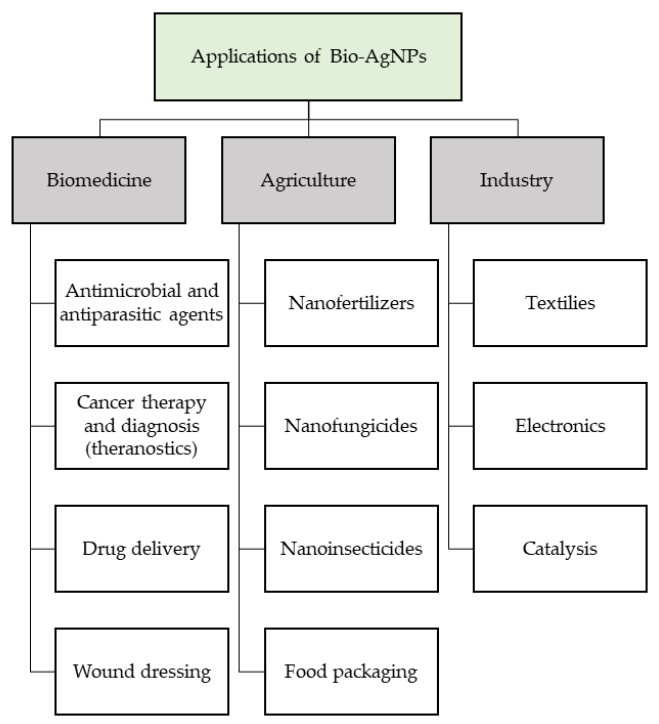
Figure 8. Multiple applications of bio-AgNPs in different fields.